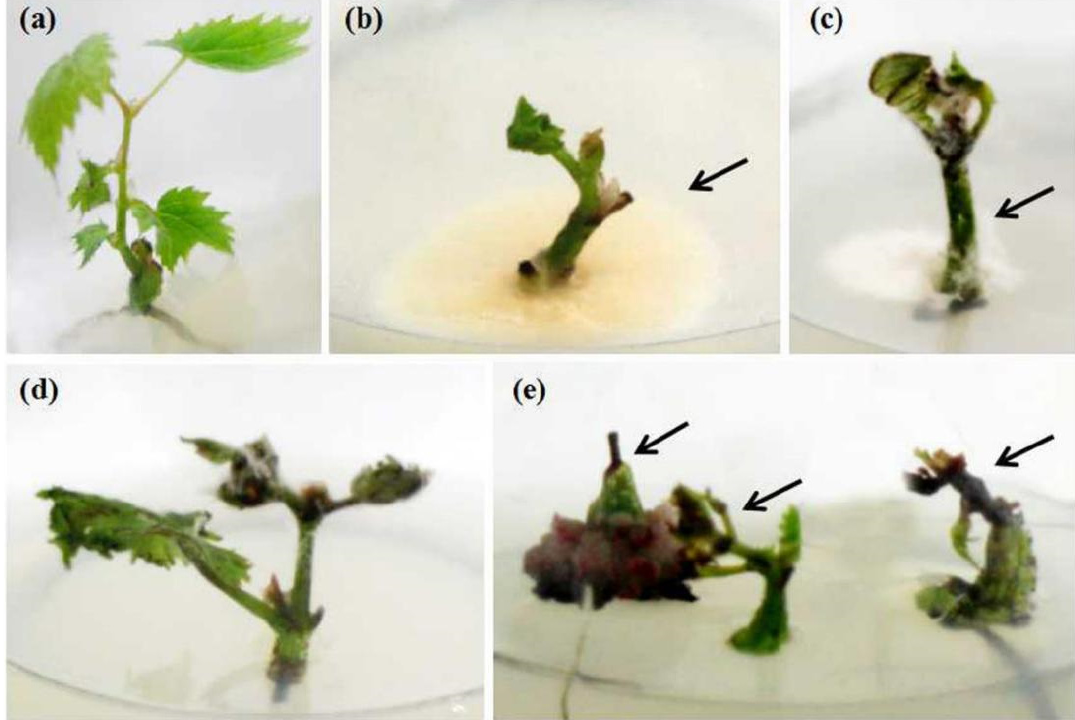
Figure 1. Factors affecting the survival of long shoot tip culture. ( a ) Survival regenerated grapevine plants; ( b ) Contamination of bacteria; ( c , d ) Contamination of fungi; ( e ) Callus of shoot tip base and browning of shoot tip top.